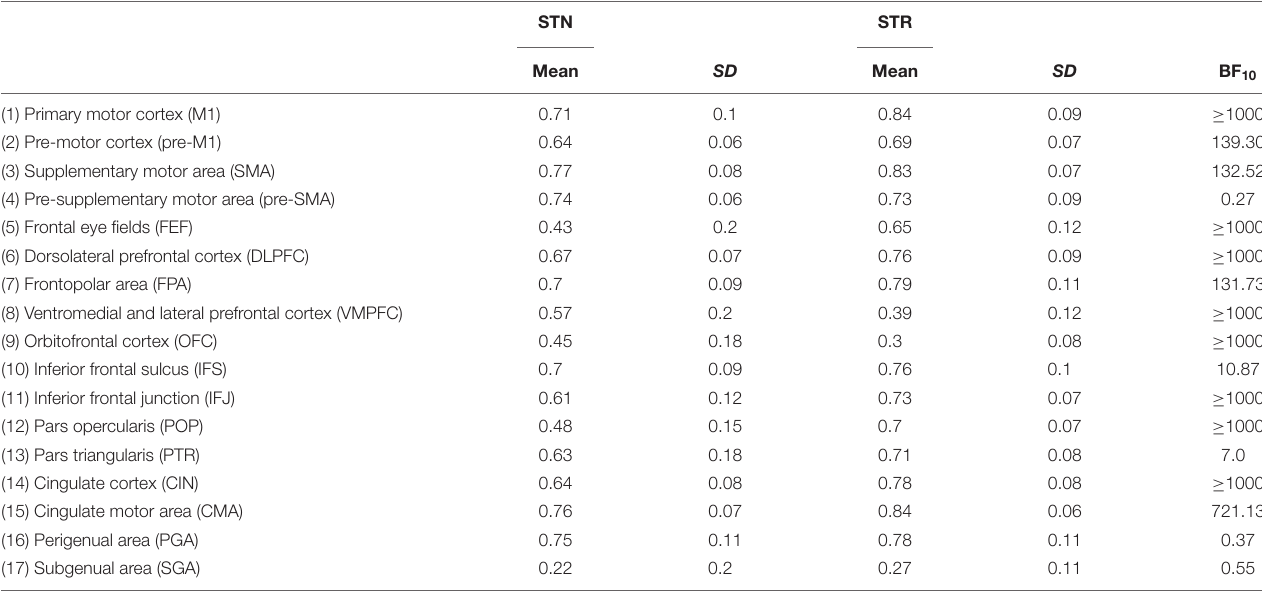
TABLE 5 | Summary statistics of the tract strengths for the STN and STR to cortex averaged over hemispheres.